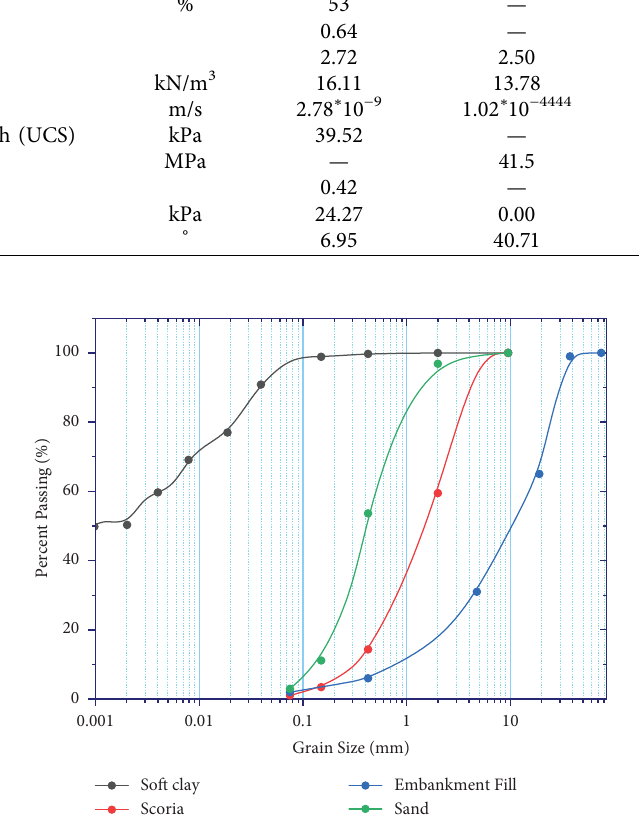
Figure 1: Particle size distribution of the soft clay, scoria, embankment fll, and sand